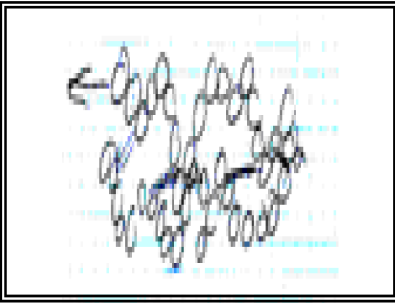
FIG. 8 (color online). The atoms of the wooden block skim over the top atoms of the table surface once it is in